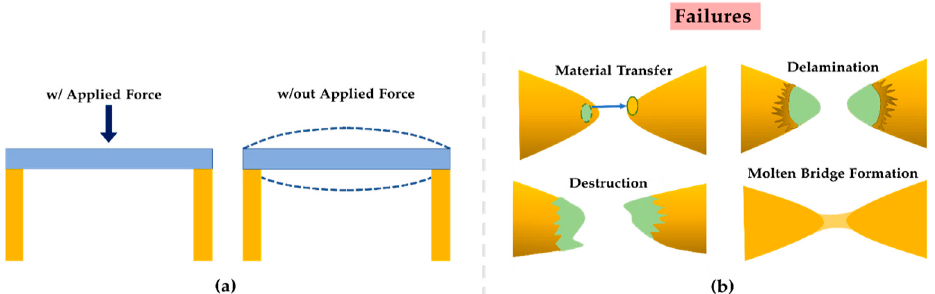
Figure 1. Microcontact failure mechanisms; ( a ) switching dynamics (contact force and contact bounce); ( b ) microcontact surface tribology (i.e., material transfer, delamination, degradation and bridge formation) after a certain number of switching cycles.